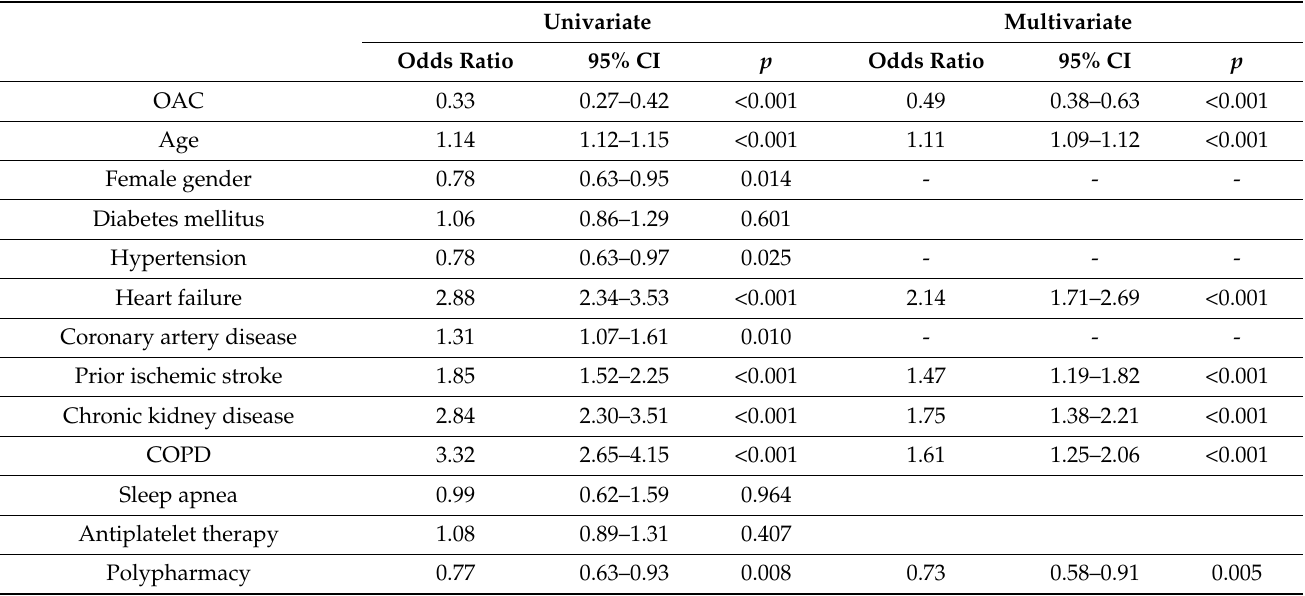
Table 3. Predictors of the composite outcome (all-cause death/any thromboembolism) among patients with atrial fibrillation and